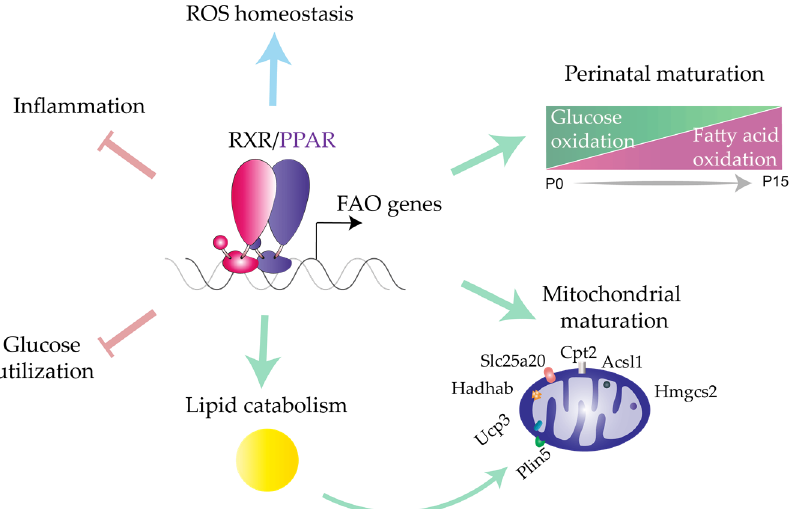
Figure 4. Cardiac-related PPARs function. Schematic representation of physiological cardiac-related processes where PPAR/RXR functioning is involved. Blue arrows denote homeostatic regulation. Green arrows denote induction. Red arrows denote inhibition. RXR, retinoid X receptor. PPAR, peroxisome proliferator-activated receptor. FAO, fatty acid oxidation. ROS, reactive oxygen species. P0, postnatal day 0. P15, postnatal day 15. Some PPAR mitochondrial target genes are depicted: Ucp3 (Uncoupling protein 4), Plin (Perilipin 5), Hmgcs2 (3-Hydroxy-3-Methylglutaryl-CoA Synthase 2), Acsl1 (Acyl-CoA Synthetase Long Chain Family Member 1), Cpt2 (Carnitine Palmitoyltransferase 2), Slc25a20 (Solute Carrier Family 25 Member 20), Hadha/b (Hydroxyacyl-CoA Dehydrogenase Trifunctional Multienzyme Complex Subunit Alpha and Beta).